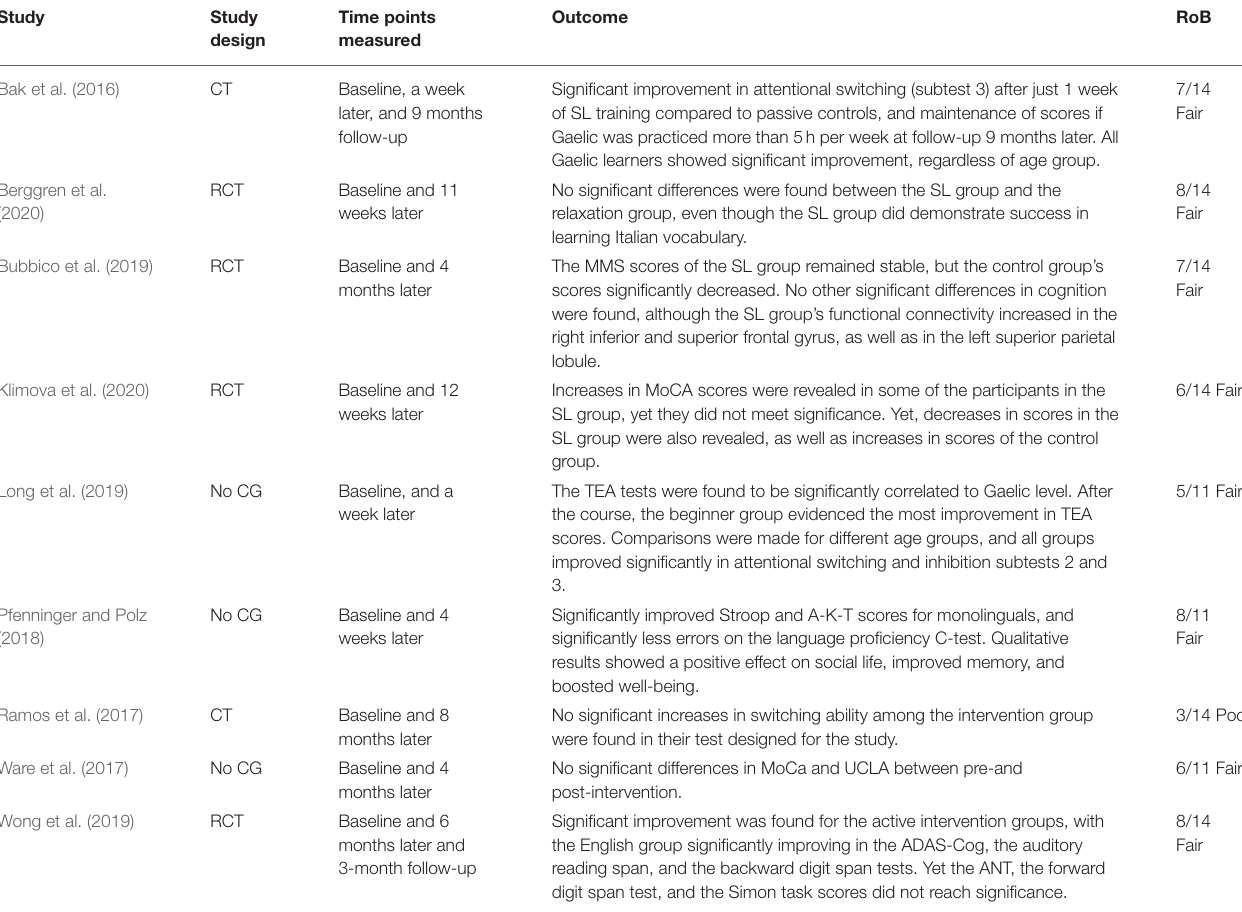
TABLE 4 | Summary of